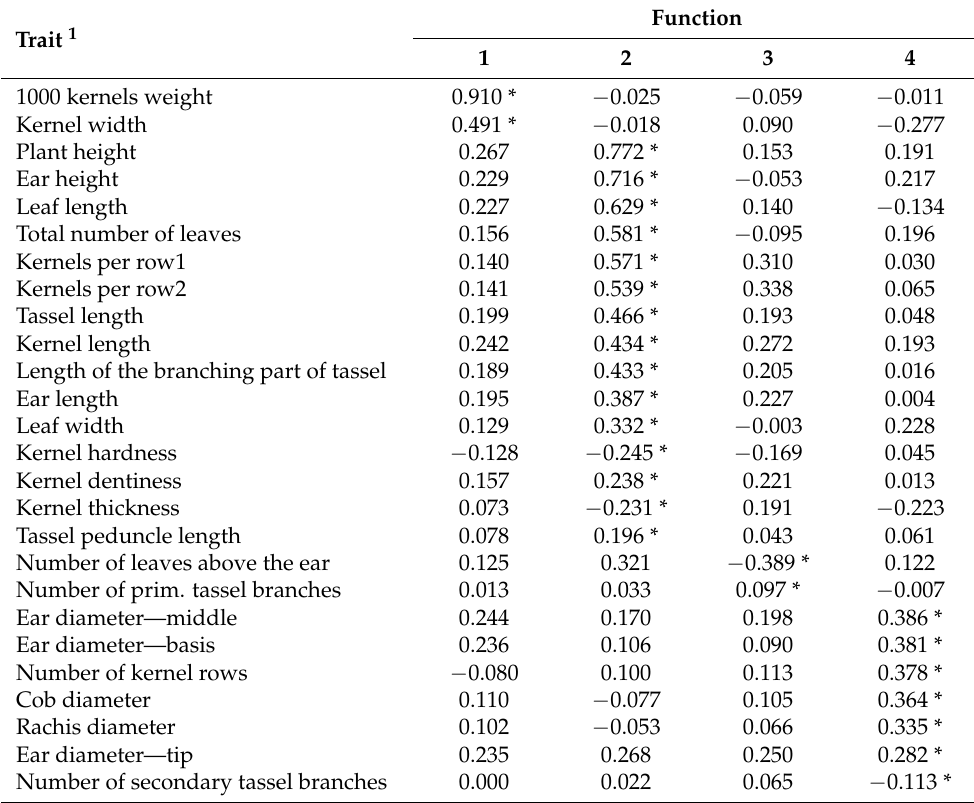
Table 4. Pooled within-groups correlations between discriminant variables and standardized canoni- cal discriminant functions.